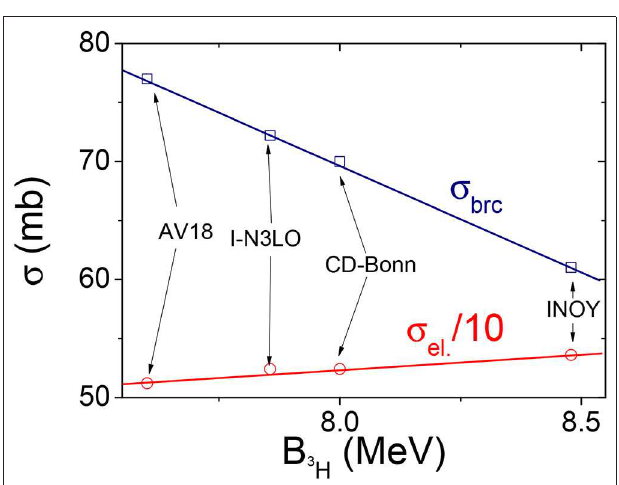
FIGURE 8 | Dependence of the calculated n- 3 H total elastic and inelastic (breakup) cross-sections on the triton binding energy for different nuclear models. Calculations have been performed for neutrons with laboratory energy of 22.1